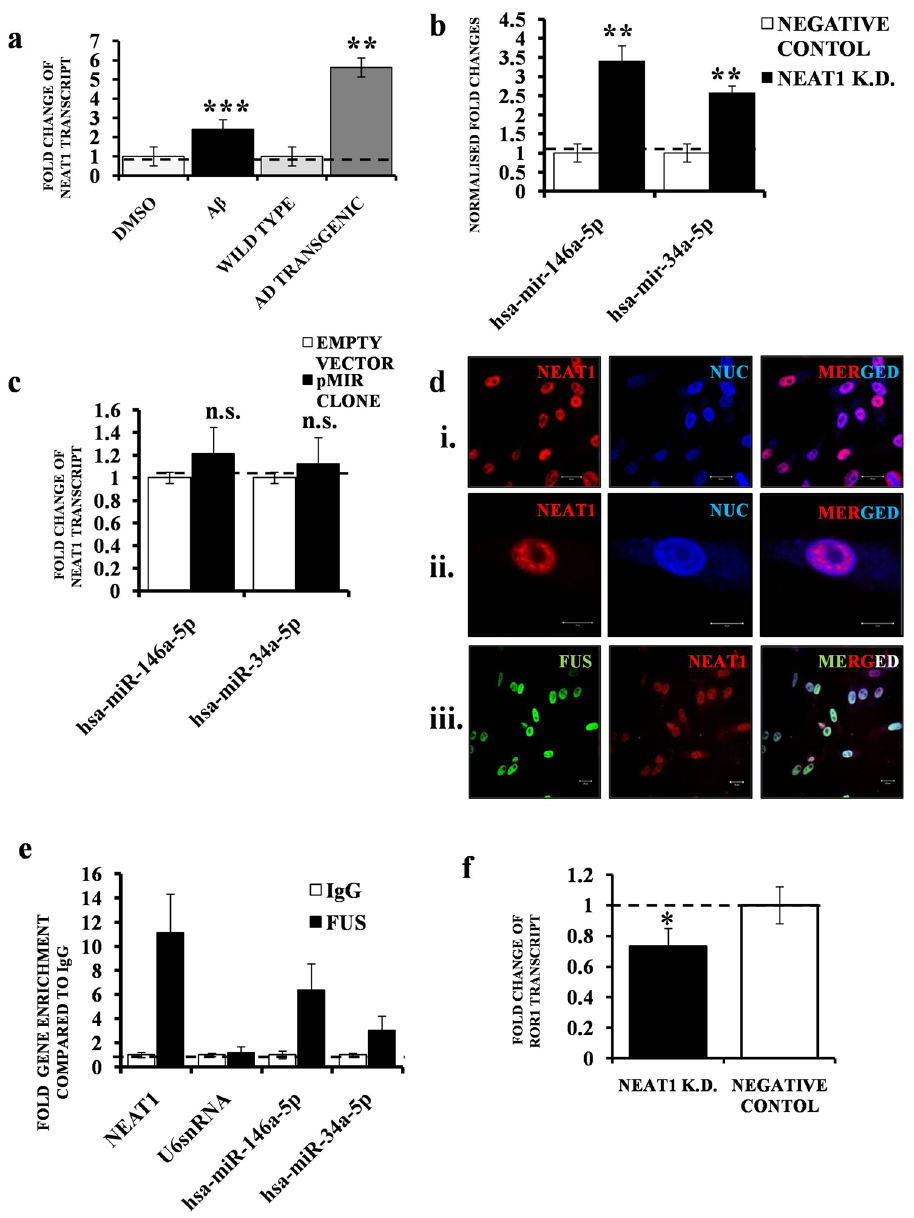
Figure 5. Endogenous interaction and regulation of miR146a and miR-34a by NEAT1 in SHSY5Y cells. ( a ) Graph depicting three (n = 3) independent biological replicates quantifying levels of NEAT1 by qRT-PCR in SHSY-5Y cells treated with 1 µM Aβ 1–42 or treated with only DMSO; wild type and AD transgenic mice. ( b ) Graph depicting three (n = 3) independent biological replicates quantifying levels of miR146a and miR-34a by qRT-PCR in SHSY-5Y cells treated with NEAT1 siRNA or corresponding negative control. ( c ) Graph depicting three (n = 3) independent biological replicates quantifying levels of NEAT1 by qRT-PCR in SHSY-5Y cells treated with hsa-mir-146a-5p and hsa-mir-34a-5p pMIR clones or corresponding empty vector controls. ( d ) RNA-FISH assay of NEAT1 in SHSY5Y cells showing its enrichment in the areas of the nucleus distinct from the nuclear stain DRAQ5®; panel (i) Low magnification (1x) image of a cell population. Scale bars, 20 μm; panel (ii). High magnification (4x) image of a single nucleus distinct NEAT1 paraspeckles. Scale bars, 5 μm; panel (iii). Co localization Analysis—Sequential Immunocytochemistry (ICC) and RNA Fluorescence In Situ Hybridisation (FISH) assay of NEAT1 combined with FUS in SHSY-5Y cells—Low magnification (1x) image of a cell population. Scale bars, 20 μm. For each FISH or combined ICC-FISH experiment, images of at least 30 cells (or cell fields) were captured and the experiments were repeated thrice (n = 3). ( e ) Graph depicting three (n = 3) independent biological replicates quantifying enrichment of NEAT1, U6snRNA, hsa-mir-146a-5p and hsa-mir-34a-5p by qRT-PCR in SHSY-5Y cells after pull down with FUS antibody or control IgG antibody in RIP Assays. Levels of U6snRNA were taken as endogenous control. The levels of individual miRNAs or lncRNA were normalized by the corresponding U6snRNA levels. Fold change was calculated by considering the relative levels of miRNAs or lncRNA in scrambled controls to be 1. ( f ) Graph depicting three (n = 3) independent biological replicates quantifying levels of ROR1 by qRT-PCR in SHSY-5Y cells treated with NEAT1 siRNA or corresponding negative control. Error bars indicate ± SD. Significance level between different experimental pairs is shown (NS, not significant; * p < 0.05; ** p < 0.01; *** p <